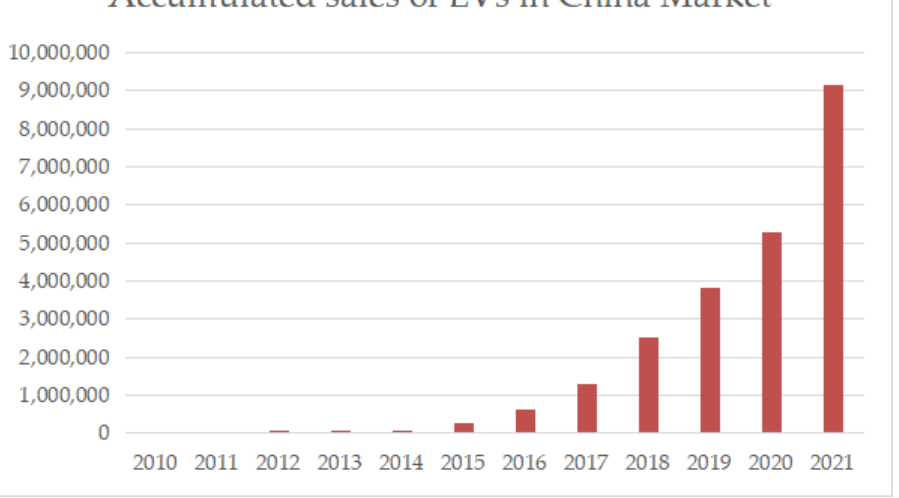
Figure 1. Accumulated sales of EVs in China, data source: MarkLines database.